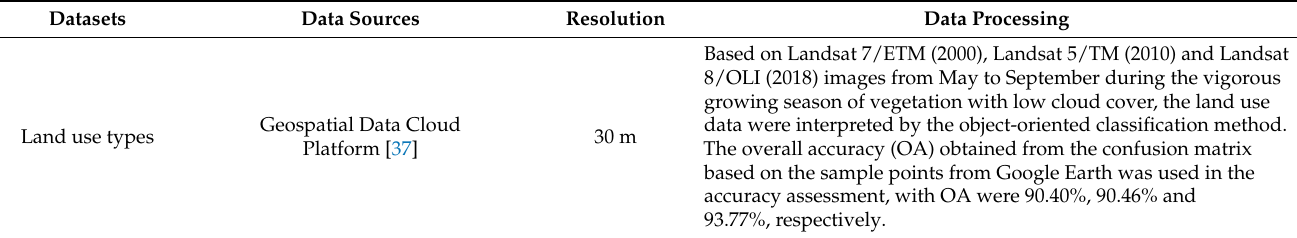
Table 1. Data sources and